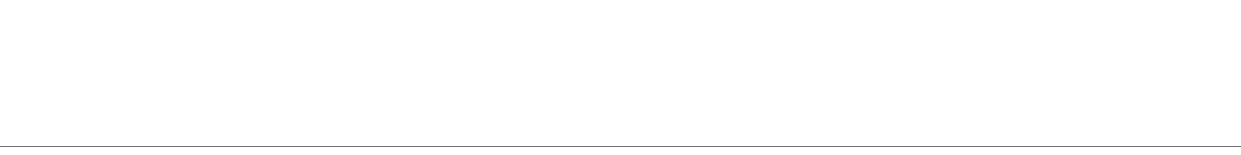
Frontiers in Genetics |